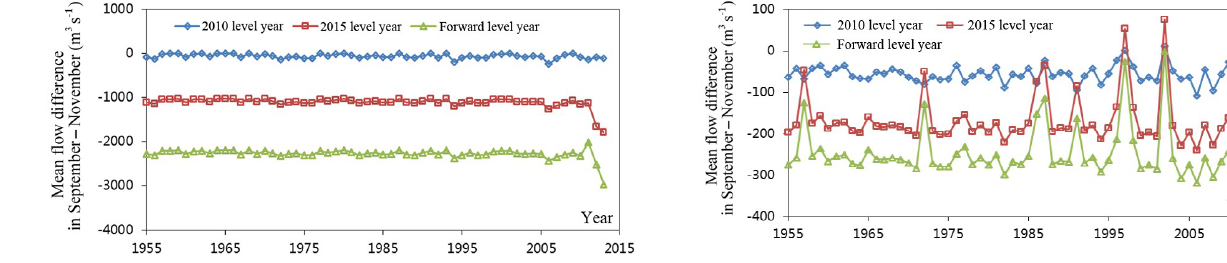
Figure 11. Process of mean flow of Beibei hydrological station from September to November in different level years and the natural condition.